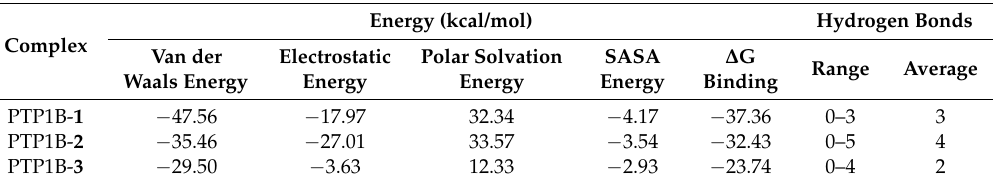
Table 3. Binding free energies determined by the MMPBSA method, and hydrogen bonds of the protein-ligand complexes. Energy (kcal/mol) Hydrogen Bonds Complex Van der Waals Electrostatic Polar Solvation Energy Energy Energy